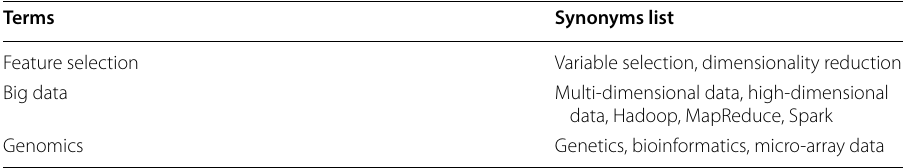
Table 1 Keywords and synonyms in the search query Terms Feature